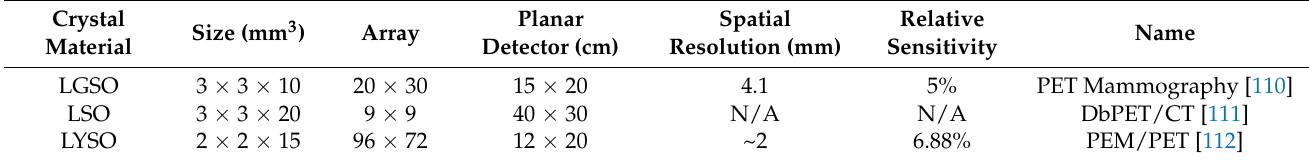
Table 5. Scintillation crystals used in Db-PET and their